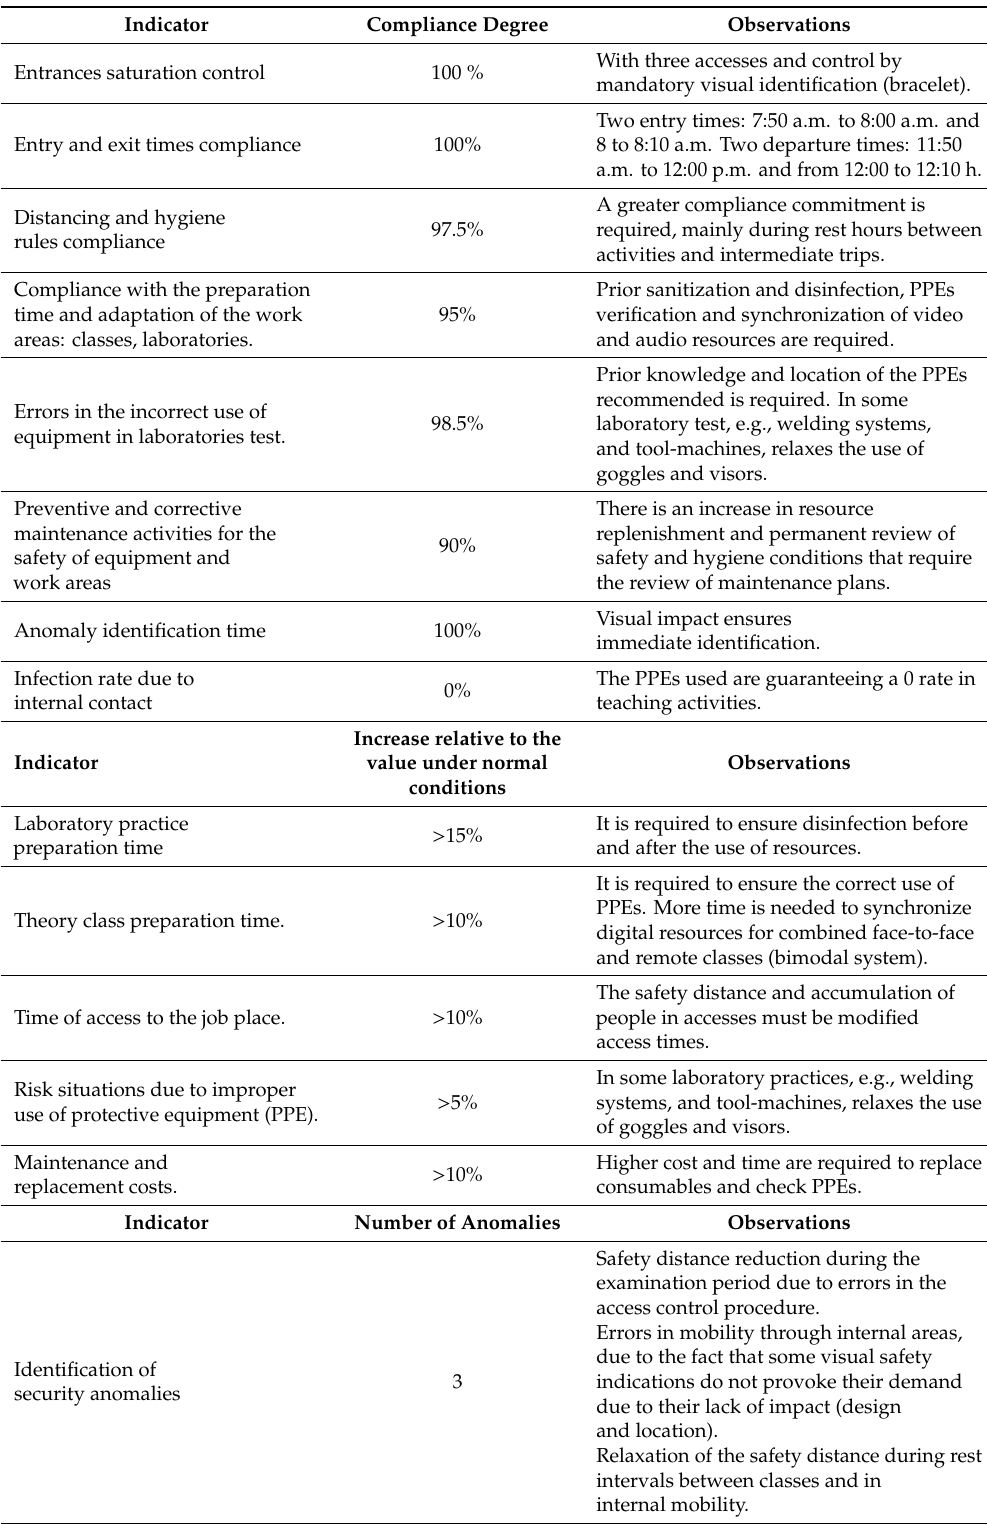
Table 7. Implantation